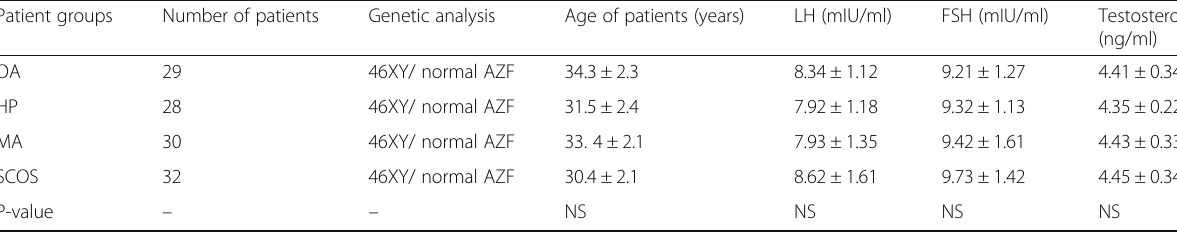
Table 1 The clinical features of patient groups Patient